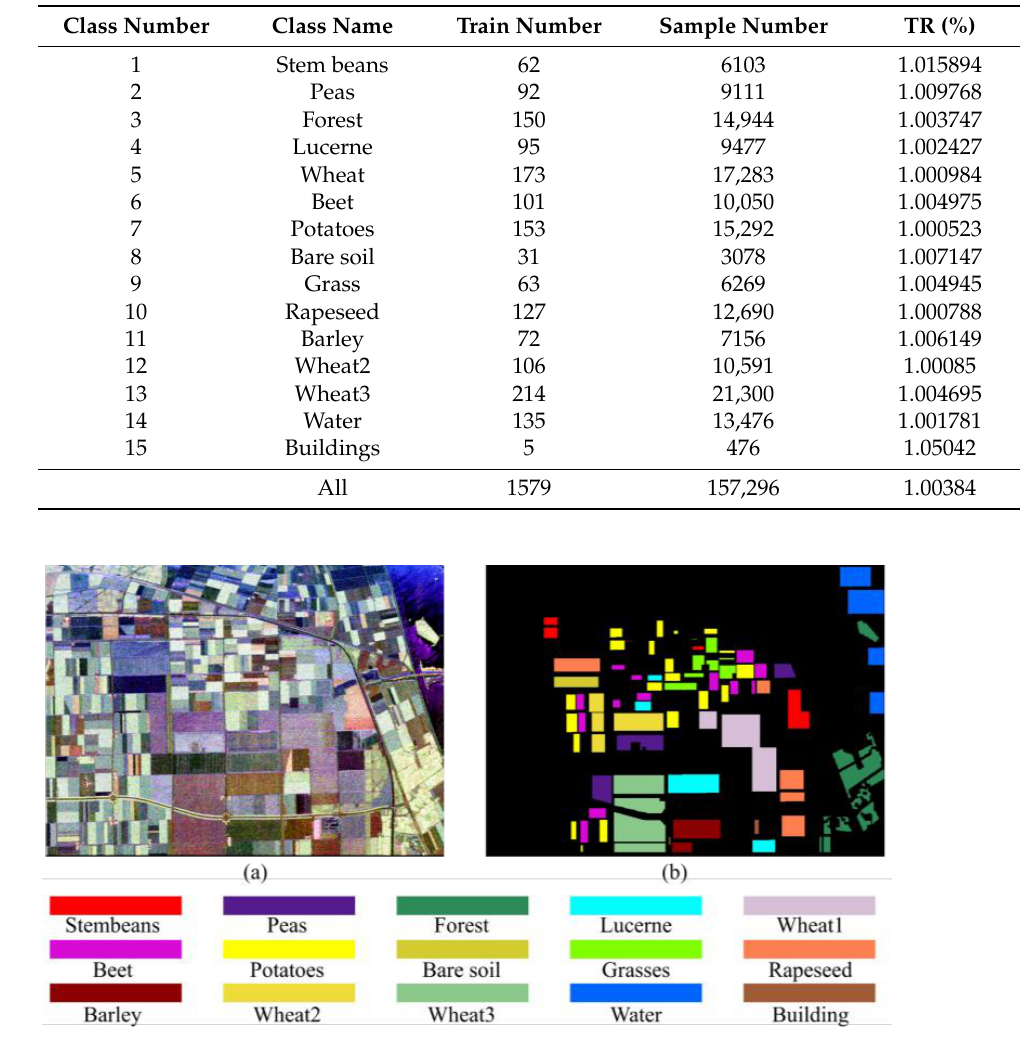
Figure 5. ( a ) Pauli RGB and ( b ) ground truth map of AIRSAR Flevoland data. (2) AIRSAR San Francisco data: The San Francisco data also comprise an L-band full Table 1. Details of classes and training samples for AIRSAR Flevoland data (TR represents training polarimetric image captured by the AIRSAR platform in 1989 over San Francisco, USA. ratio). The image has a resolution of 900 × 1024 pixels and 802,302 GT labeled pixels, with five land cover categories. The GT is accessible from [45]. Details of GT categories’ names and sizes (for train and whole sample) are compared in Table 2. Figure 6a,b represent the San Francisco image’s Pauli RGB and GT. The spatial resolution of the image is 10 in both